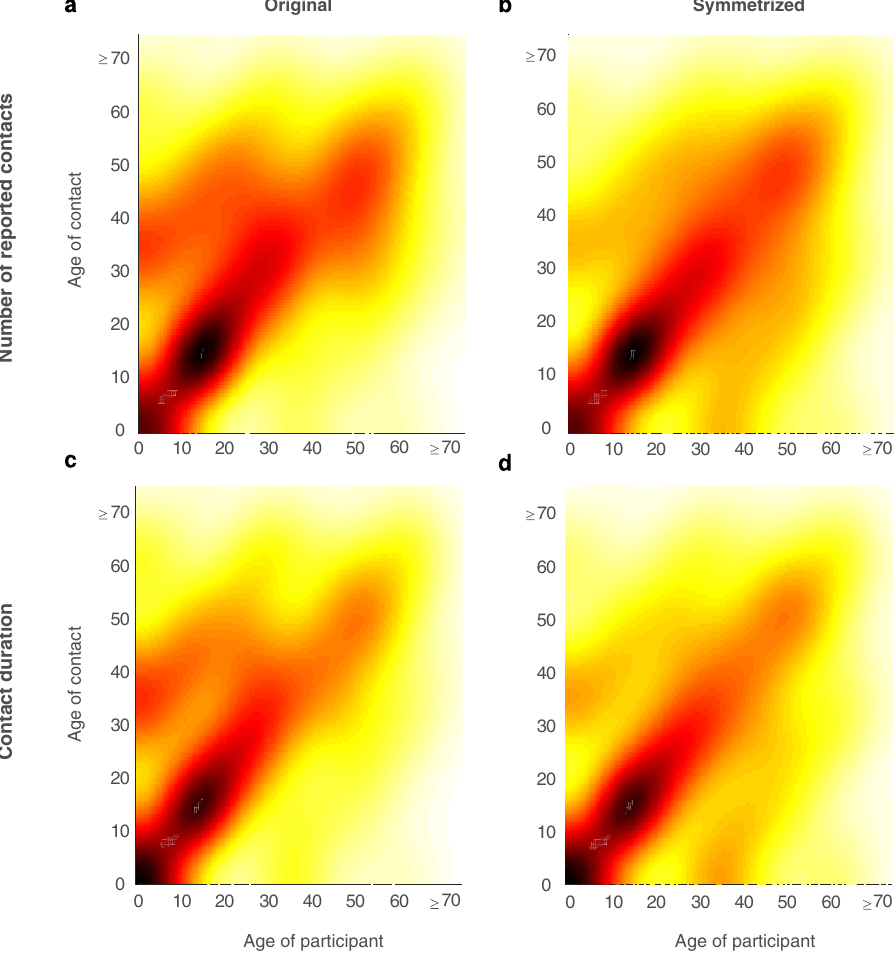
Figure 6. Smoothed contact matrix of all reported contacts and total contact durations. The smoothed contact matrices are constructed based on all contact data using kernel density estimation with a Gaussian kernel: ( a ) original number of reported contacts, ( b ) symmetrized number of reported contacts, ( c ) original contact person hours and ( d ) symmetrized contact person hours. The original contact matrices { c ij } show the average number of contacts or mean contact person hours in age group i reported by participants from age group j ; the + c c ij ji . Inverse probability of treatment weighting symmetrized contact matrices are calculated using =  c { } ij 2 (IPTW) was applied with the propensity scores for mode of survey. The bandwidth was optimized by default to estimate normal densities in MATLAB 9.0 and boundary bias were corrected with simple reflection of